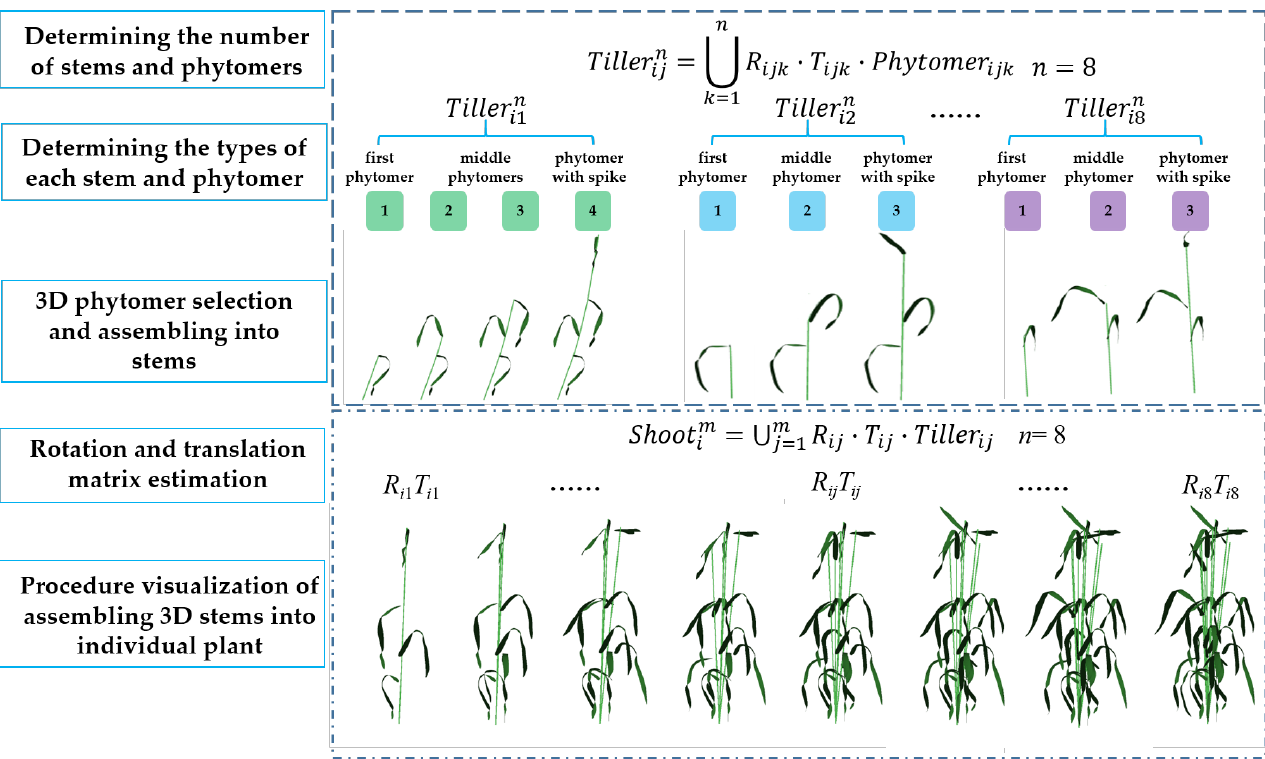
Figure 4. Geometric modeling of assembled wheat plants: from 3D phytomers to tillers and to an individual plant. In the figure above, the wheat plant consists of eight tillers, with each tiller having several phytomers. A tiller was assembled by selecting 3D phytomer templates, and determining rotation and translation matrices. Similarly, a wheat shoot was assembled by determining the rotation and translation matrices of the already constructed tiller models.